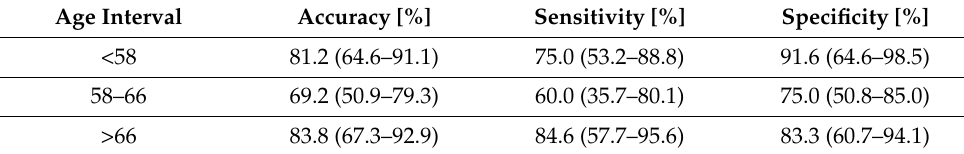
Table 10. Diagnostic performance and 95% CI of the model as a function of age. Age Interval Accuracy [%]